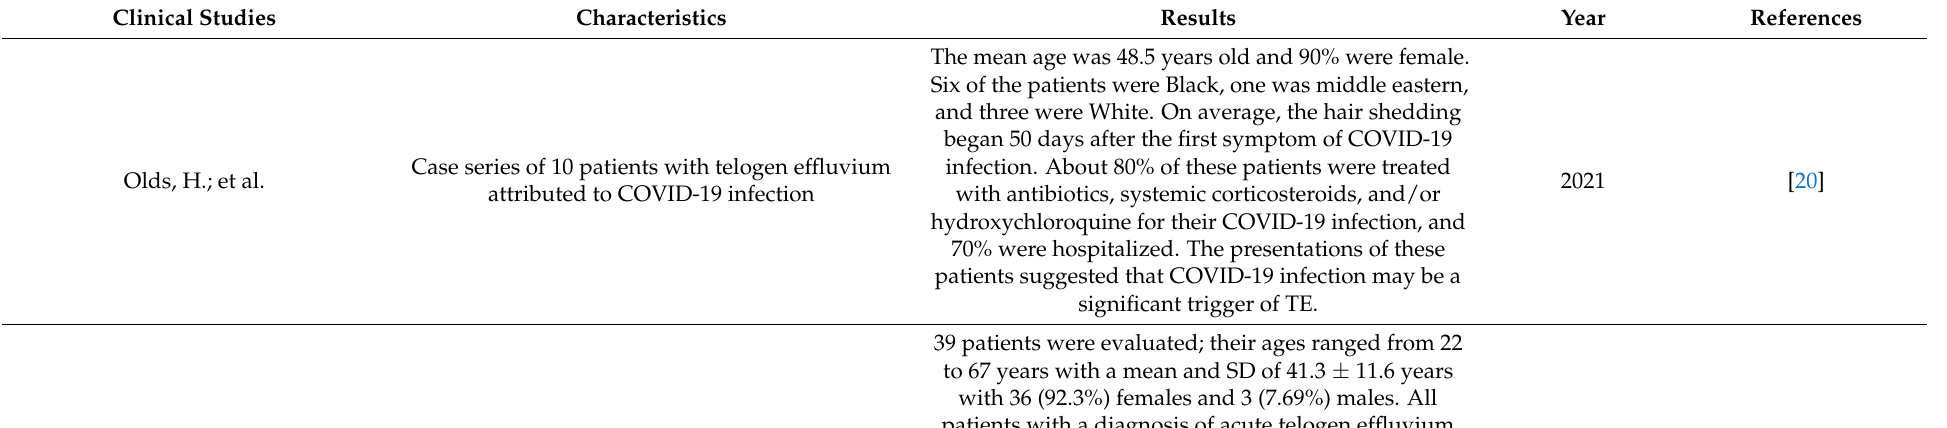
Table 2. Clinical studies on the relationship between telogen effluvium and